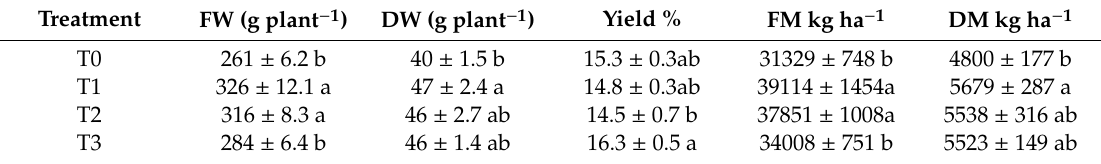
Table 3. Yield of plants. Di ff erent letters within a column represent significant di ff erences ( p ≤ 0.05).